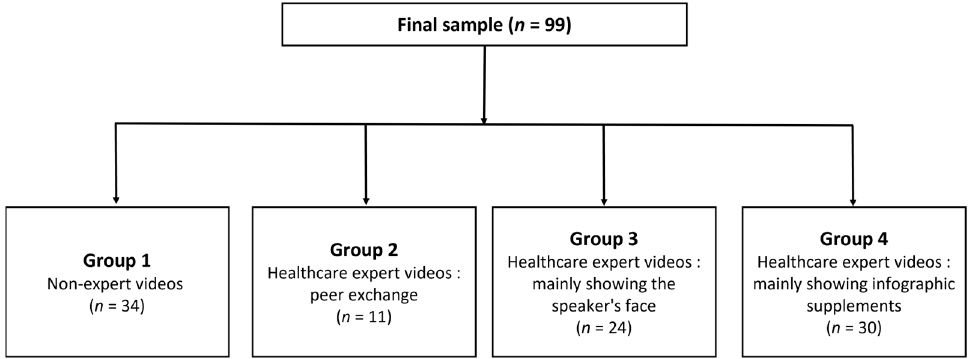
Figure 2. Subgroup of videos according to the expertise of the lecturer and educational